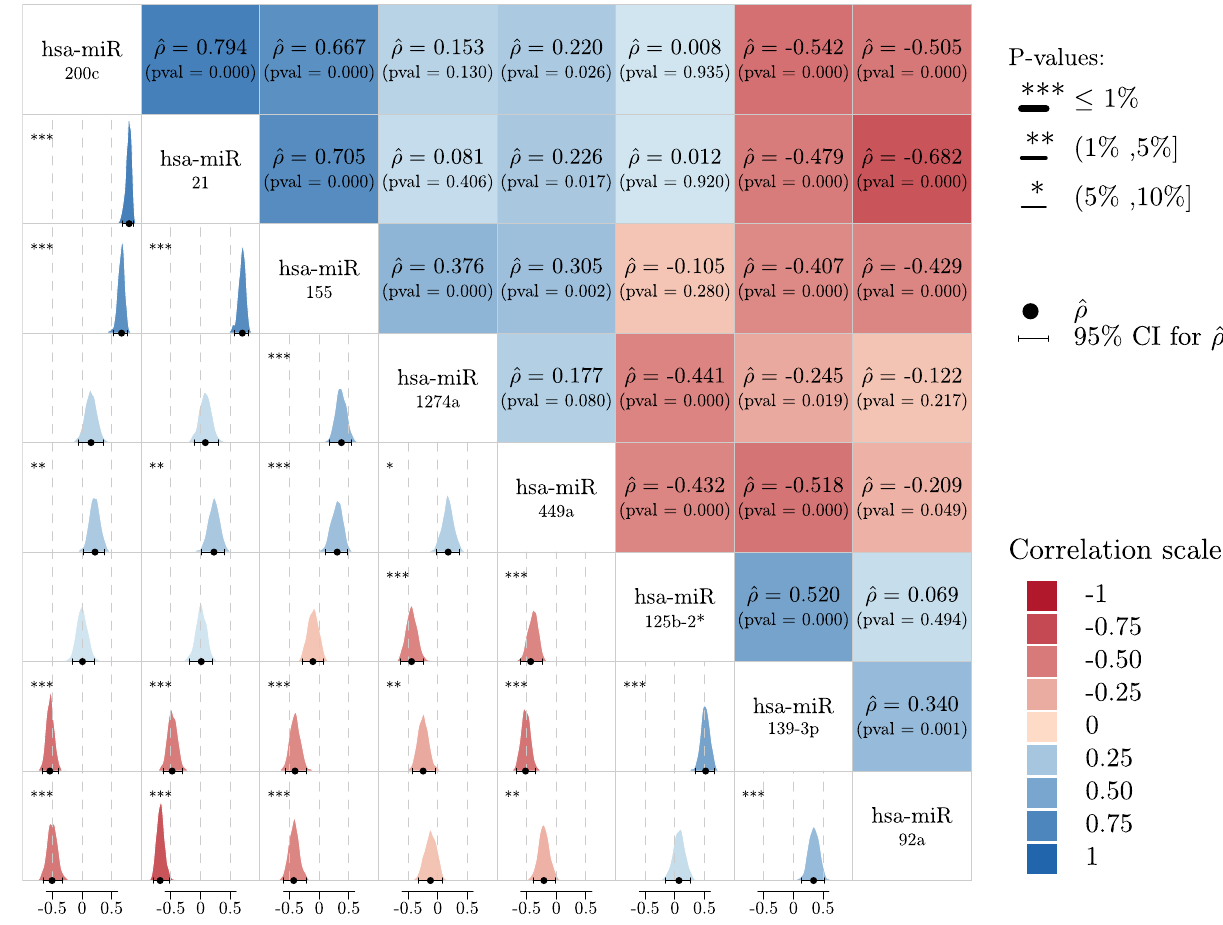
Figure 5. Spearman correlation ( ˆ ρ ) matrix for the 8 most frequent miRNAs selected by the SWAG The upper triangular part shows the estimator ˆ ρ between miRNAs and their respective p-value computed via non- parametric bootstrap. The color of the boxes indicates the direction of ˆ ρ (blue for positive correlation and red for negative). The lower triangular part illustrates the bootstrap distribution of ˆ ρ via the density plot, with the dark circle being the estimator of ˆ ρ and the horizontal black line its 95% confidence interval. The star on the boxes’ upper-left indicates the level for which the correlation in significant. miRNA Single